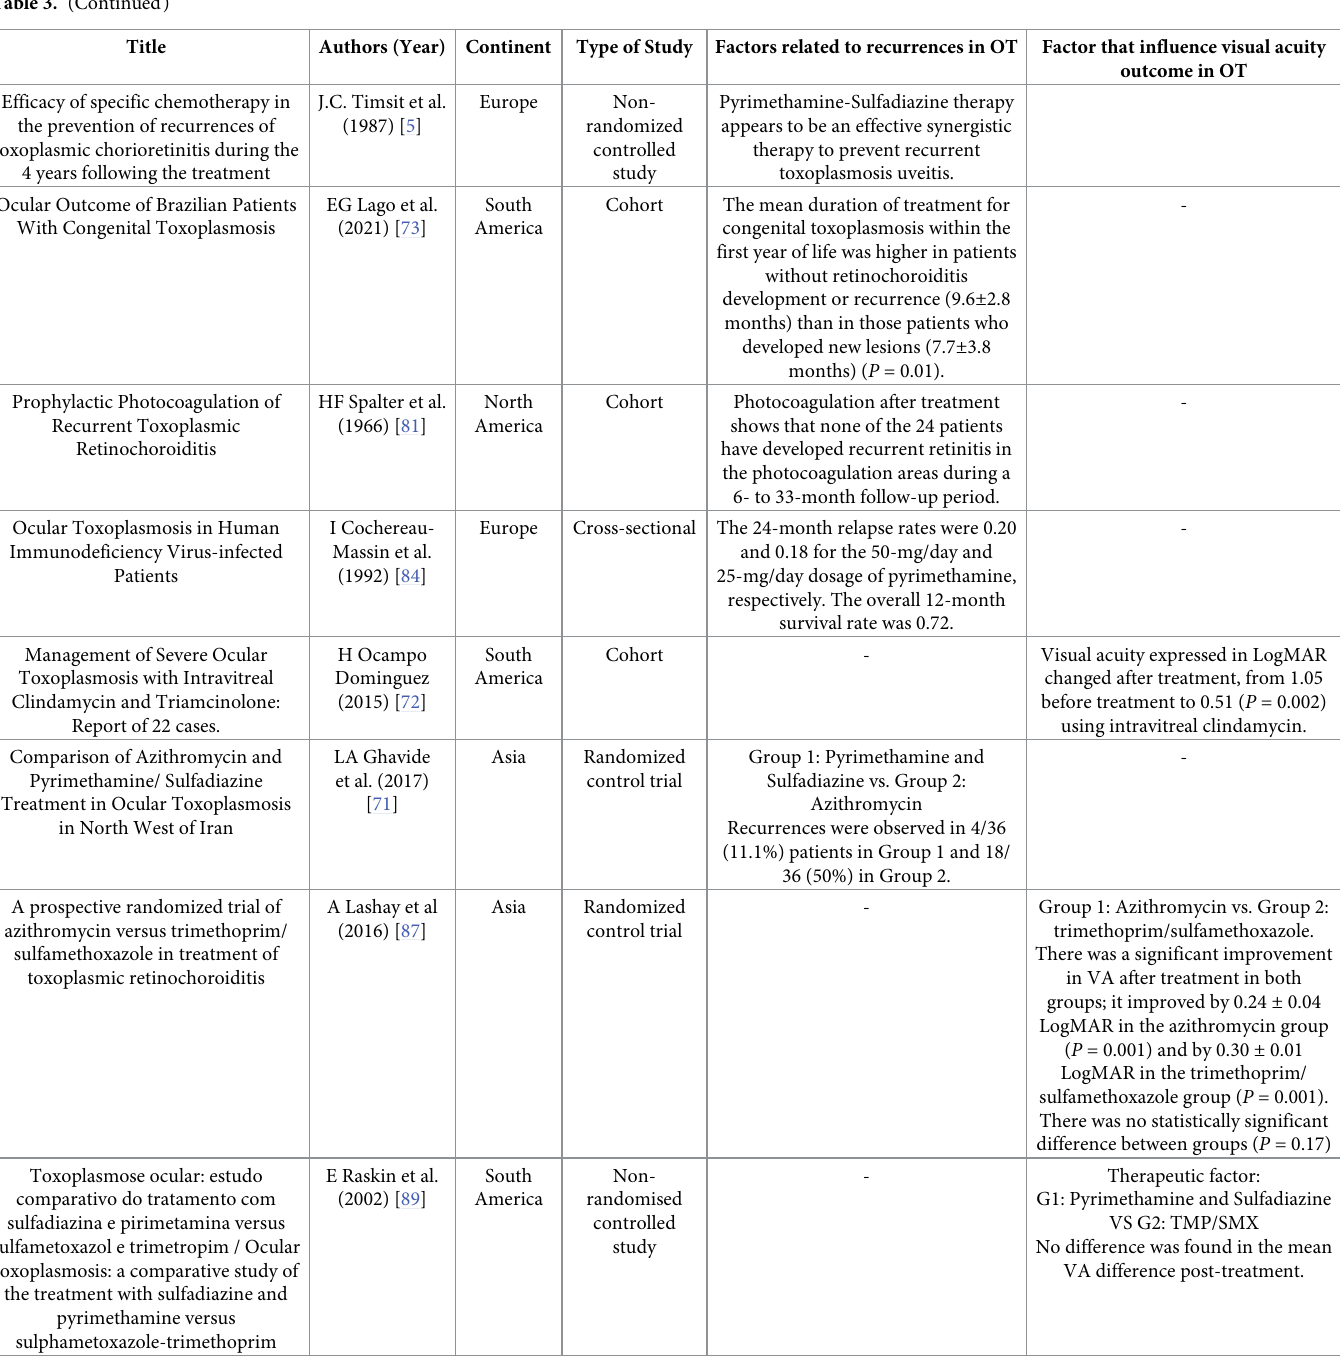
Therapeutic factor: G1: Pyrimethamine and Sulfadiazine VS G2: TMP/SMX No difference was found in the mean VA difference